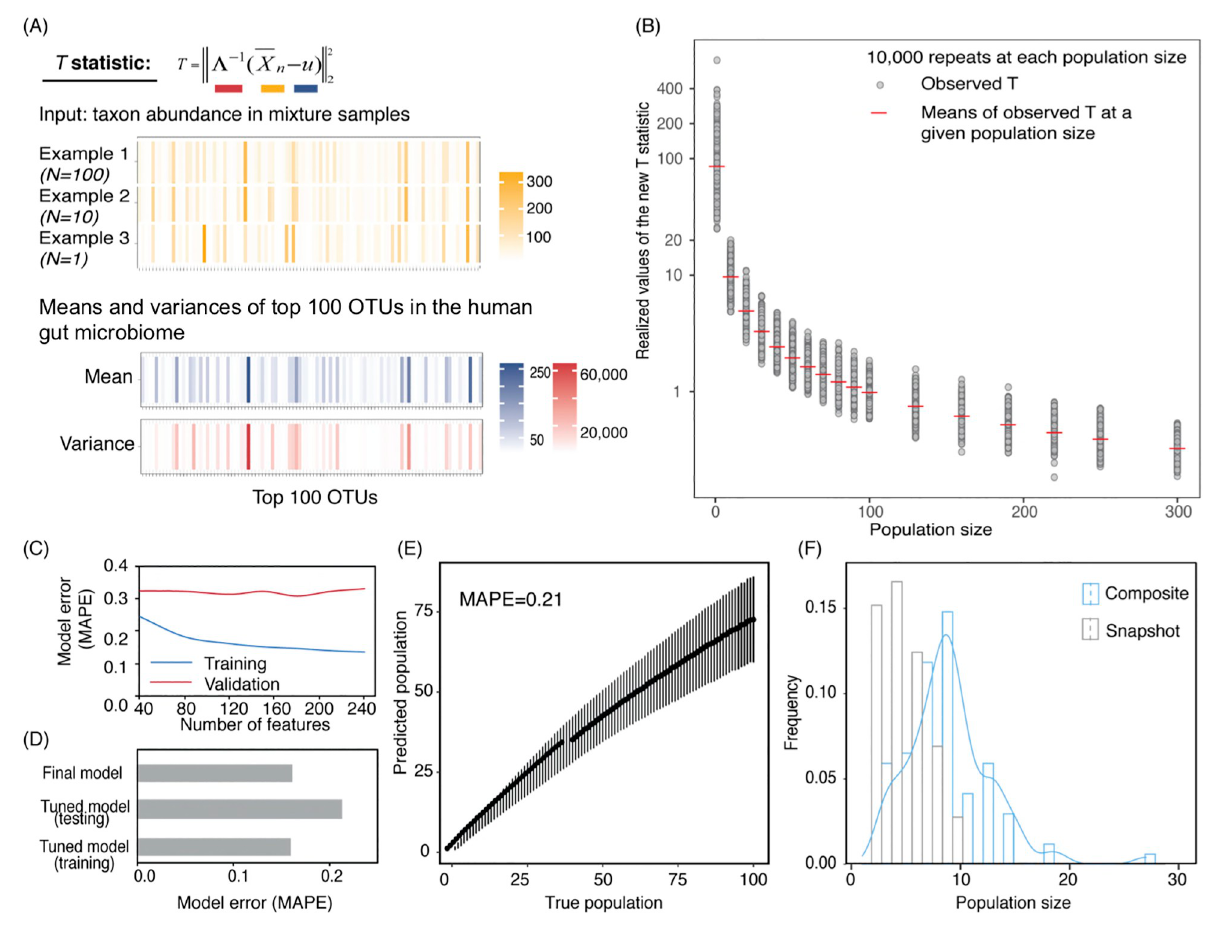
Fig 3. MicrobiomeCensus statistic definition, model training, validation, and application. (A) Example of computing the T statistic. (B) Simulation results for T with different population sizes. Grey points are simulation results. Red bars are means of 10,000 repeats performed for each population size. (C) Model training and tuning. We built the MicrobiomeCensus model using our T statistic and a maximum likelihood procedure. The training set consisted of 10,000 samples for population sizes ranging from 1–300, and 50% of the data were used to train and validate the model. Training and validation errors from different feature subsets are shown. Training errors are shown as blue lines, and validation errors are shown as red lines. (D) Model performance on simulation benchmark. After training and validation, the model utilized the top 120 abundant features. Model performance was tested on synthetic data generated from 550 different subjects not previously seen by the model. The training set consisted of 10,000 samples with population sizes from 1–300, and the testing set consisted of 10,000 repeats at the evaluated population sizes. The training error, testing error, and the error of the final model are shown. (E) Model performance evaluated using a testing set. Black solid dots indicate the means of the predicted values, and error bars indicate the standard deviations of the predicted values. (F) Application of the microbiome population model in sewage. Seventy-six composite samples (blue) were taken from three manholes on the MIT campus, and each sample was taken over 3 hours during the morning peak water usage hours. Twenty-five snapshot samples (grey) were taken using a peristaltic pump for 5 minutes at 1-hour intervals throughout a day.